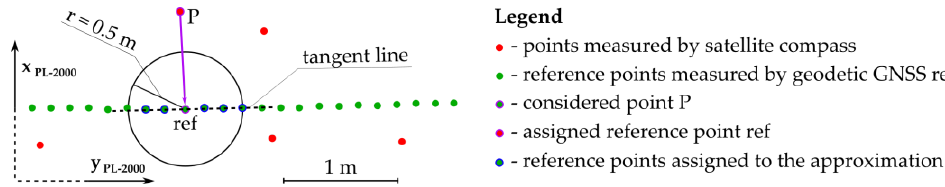
Figure 6. The determination diagram for the track tangent parameters at point P. The tangent parameters (slope and intercept) were determined with the polyfit function of the SciPy Python library. The function fits a polynomial of the predefined degree into a set of points. In the case in point, it is a straight line, so it is a first degree polynomial. Therefore, the Vandermonde matrix used in the estimation [29] is a two-column matrix. The error minimisation is the